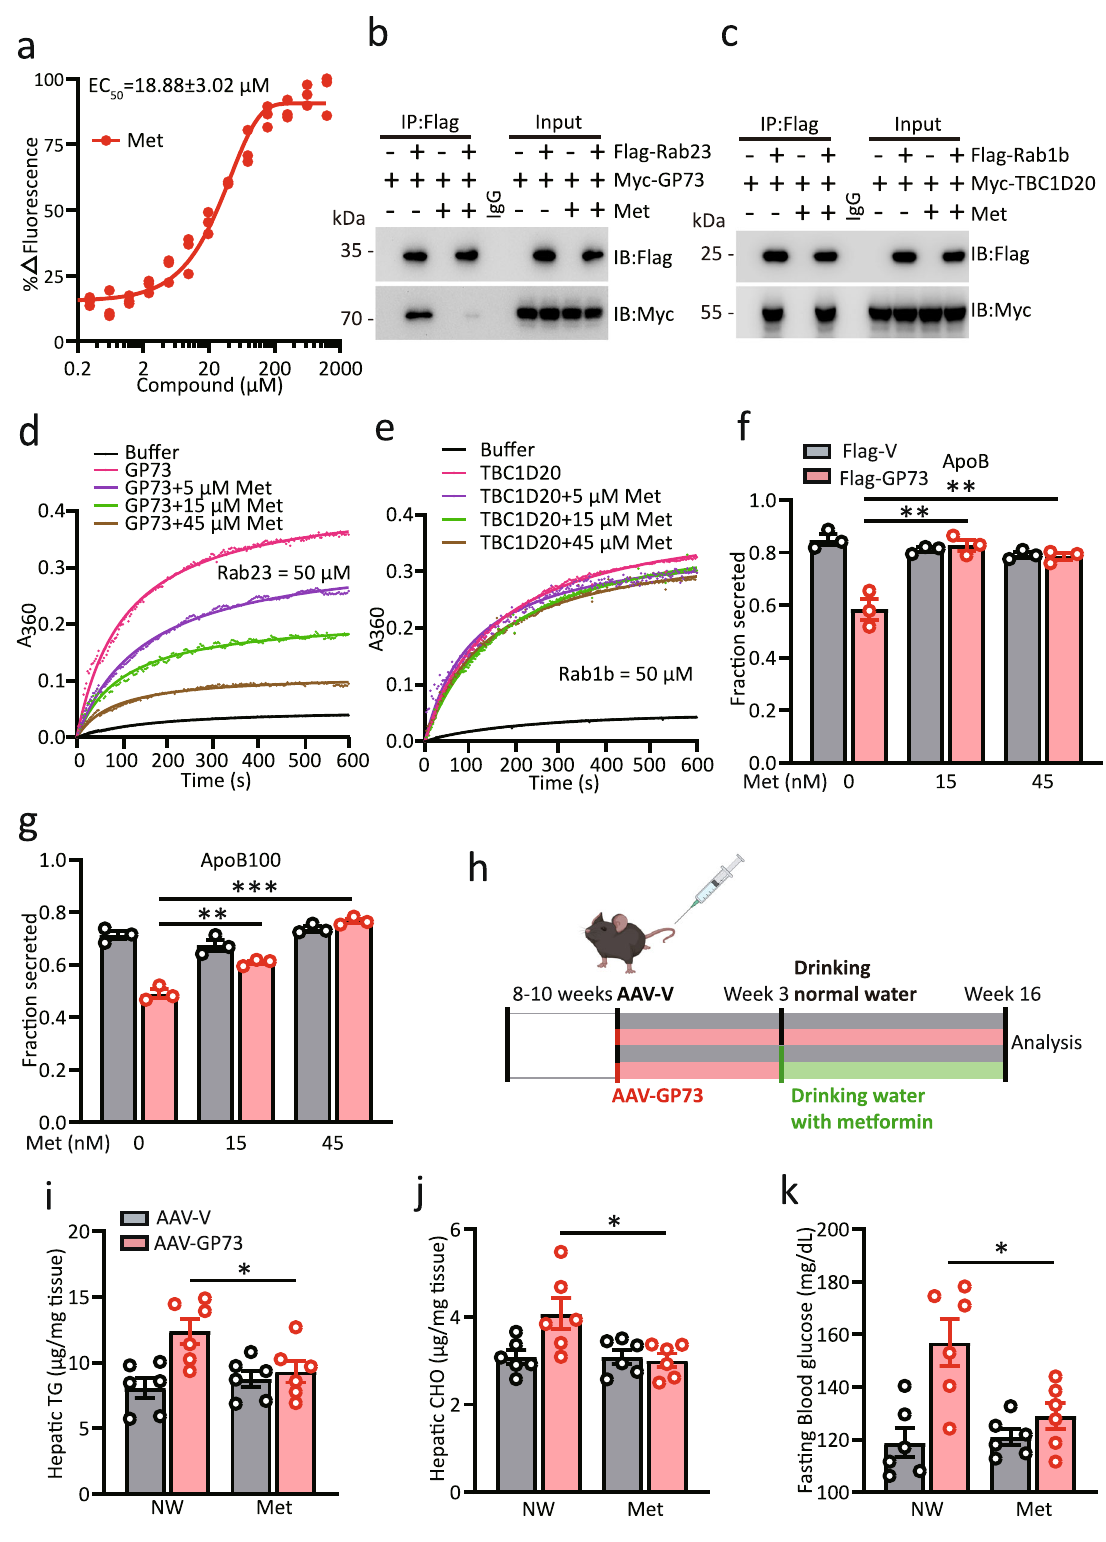
Clinical assessment . Each participant was required to complete a questionnaire for self-reported alcohol consumption, smoking and past medical history. Anthropometric data were acquired by two specialized doctors and included weight, height, waist circumference (WC), systolic blood pressure (SBP), and diastolic blood pressure (DBP). BMI was calculated as weight divided by the height squared (kg/m 2 ). Non-obese was determined by a threshold of <25kg/m 2 . After fasting overnight for ≥ 8 h, blood samples were taken for routine blood tests and